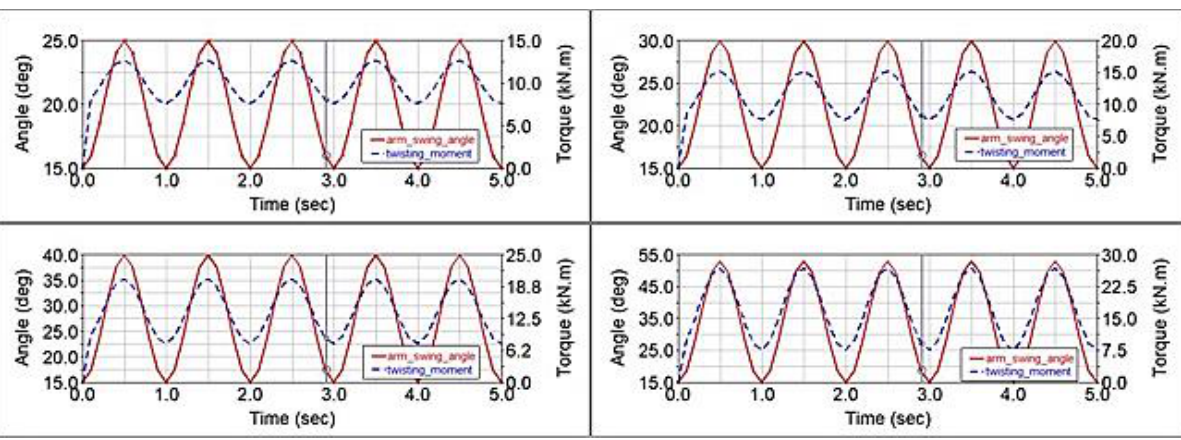
Figure 8. Simulation results for twisting moment and swing angle of road arm [16].